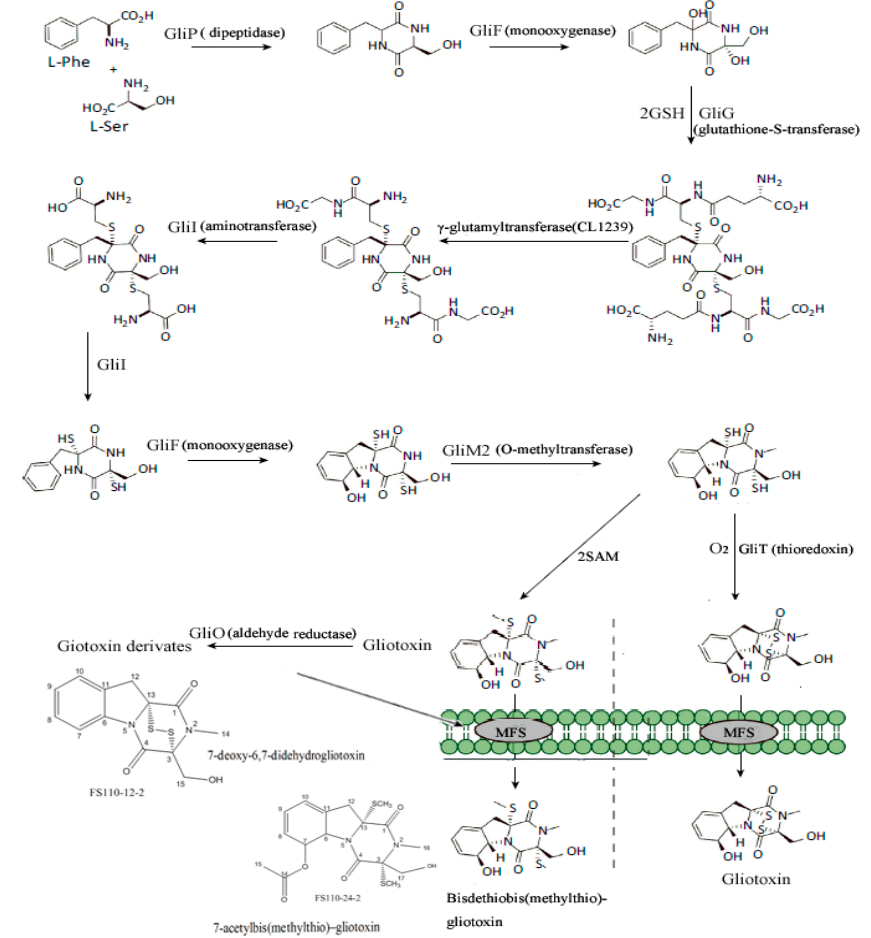
Figure 7. Proposed biosynthesis pathway of gliotoxins in D. cejpii FS110 [13]. SAM refers to S -adenosyl methionine; MFS refers to major facilitator superfamily.